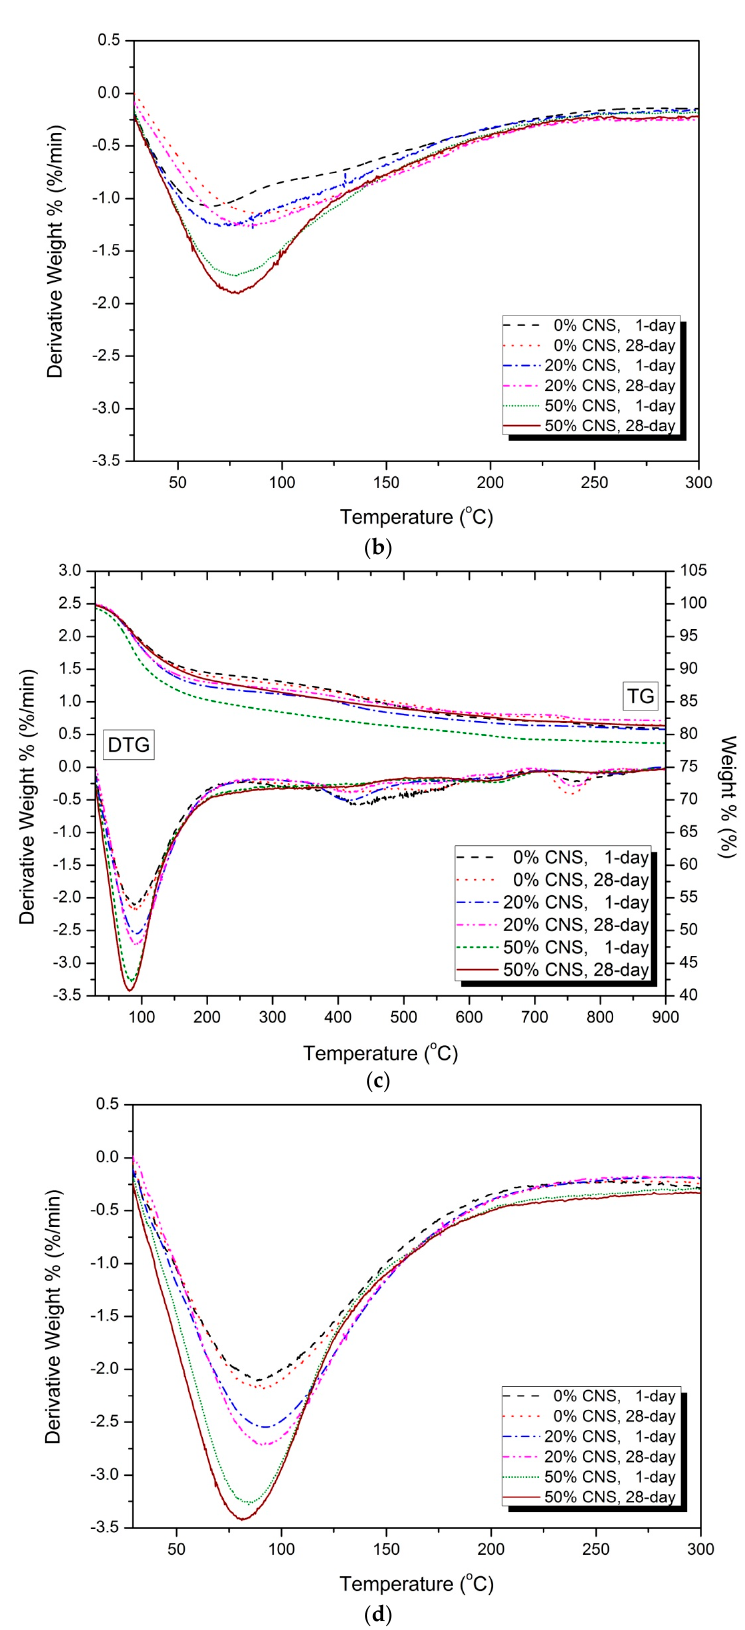
Figure 8. Thermal analysis (DTG): ( a ) 5% activator, ( b ) a magnification of less than 300 ◦ C in ( a ), ( c ) 10% activator, ( d ) a magnification of less than 300 ◦ C in ( c